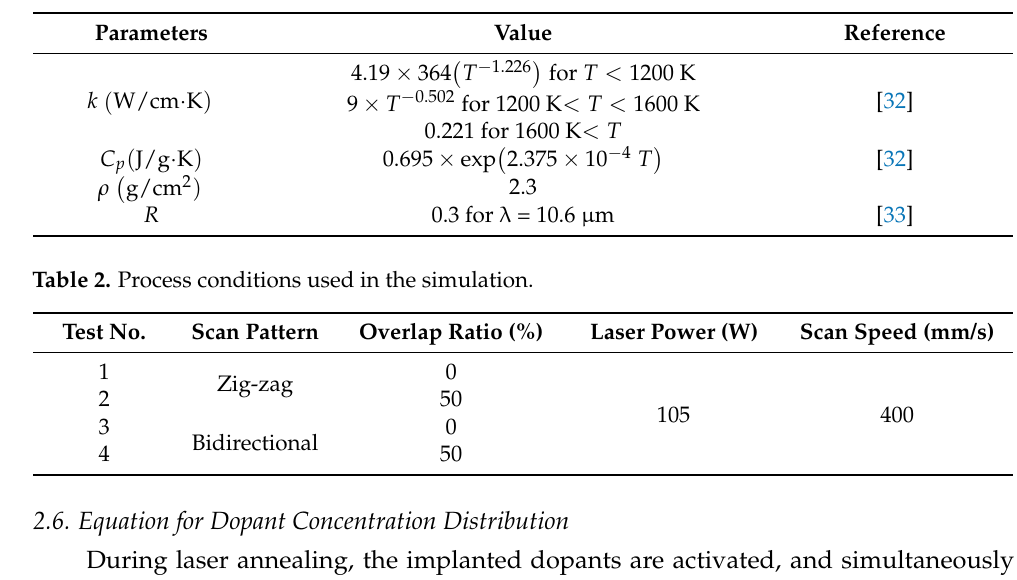
Table 1. Optical and thermo-physical properties of silicon.